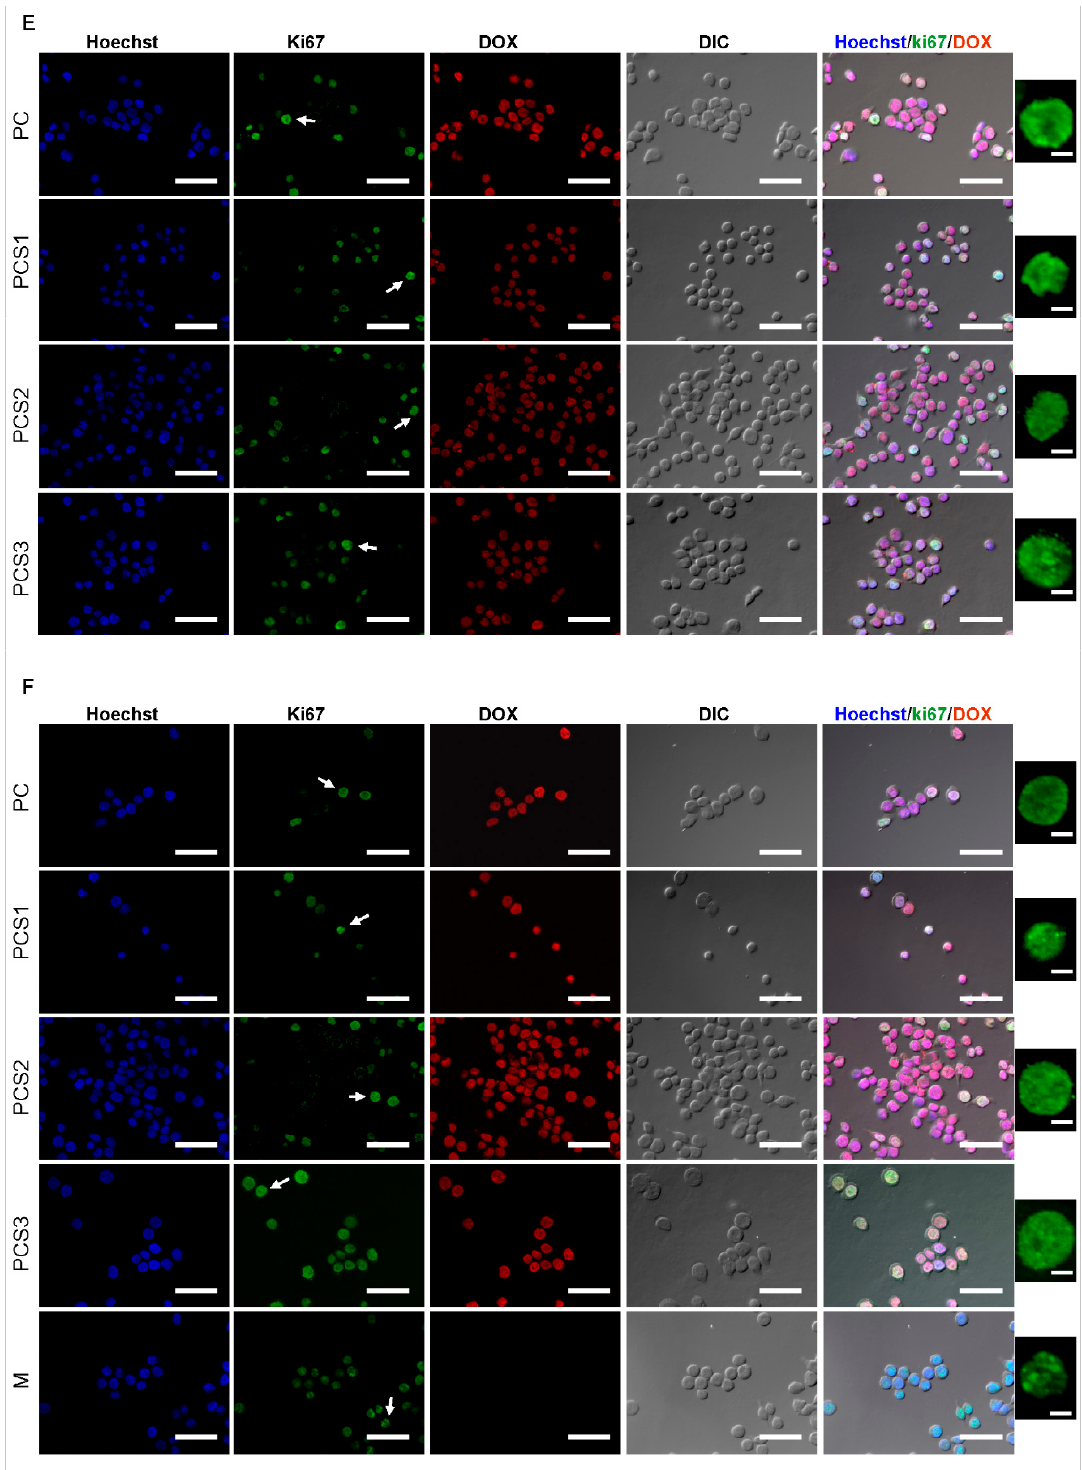
Figure 9. Fluorescence microscopy and differential interference contrast (DIC) micrographs of MDBK, HT-29 and Colo 205 cells after 30 min and 3 h of incubation with nanocomposites systems (MDBK ( A ) 30 min ( B ) 3 h, HT-29 ( C ) 30 min ( D ) 3 h, Colo 205 ( E ) 30 min, and ( F ) 3 h). DOX up-take by cells was recorded by DOX (red) and nucleus (blue) imaging by fluorescence microscopy. Cell proliferation and cell cycle were detected by specific labeling with Ki67 (green) of proliferating cells and visualizing with 40 × objective (scale bar, 50 µ m). Nuclear localization (white arrow) of Ki67 was detected in cells in different phases of the cell cycle (small pictures on the right, scale bar, 5 µ m). M-cells without nanocomposites treatment.